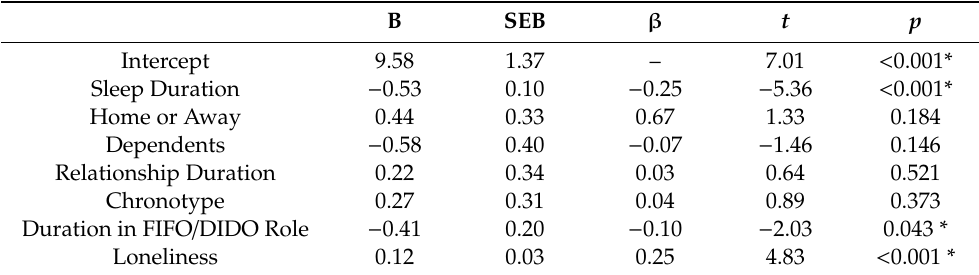
Table 3. Results of Multiple Regression Analysis Predicting Sleep